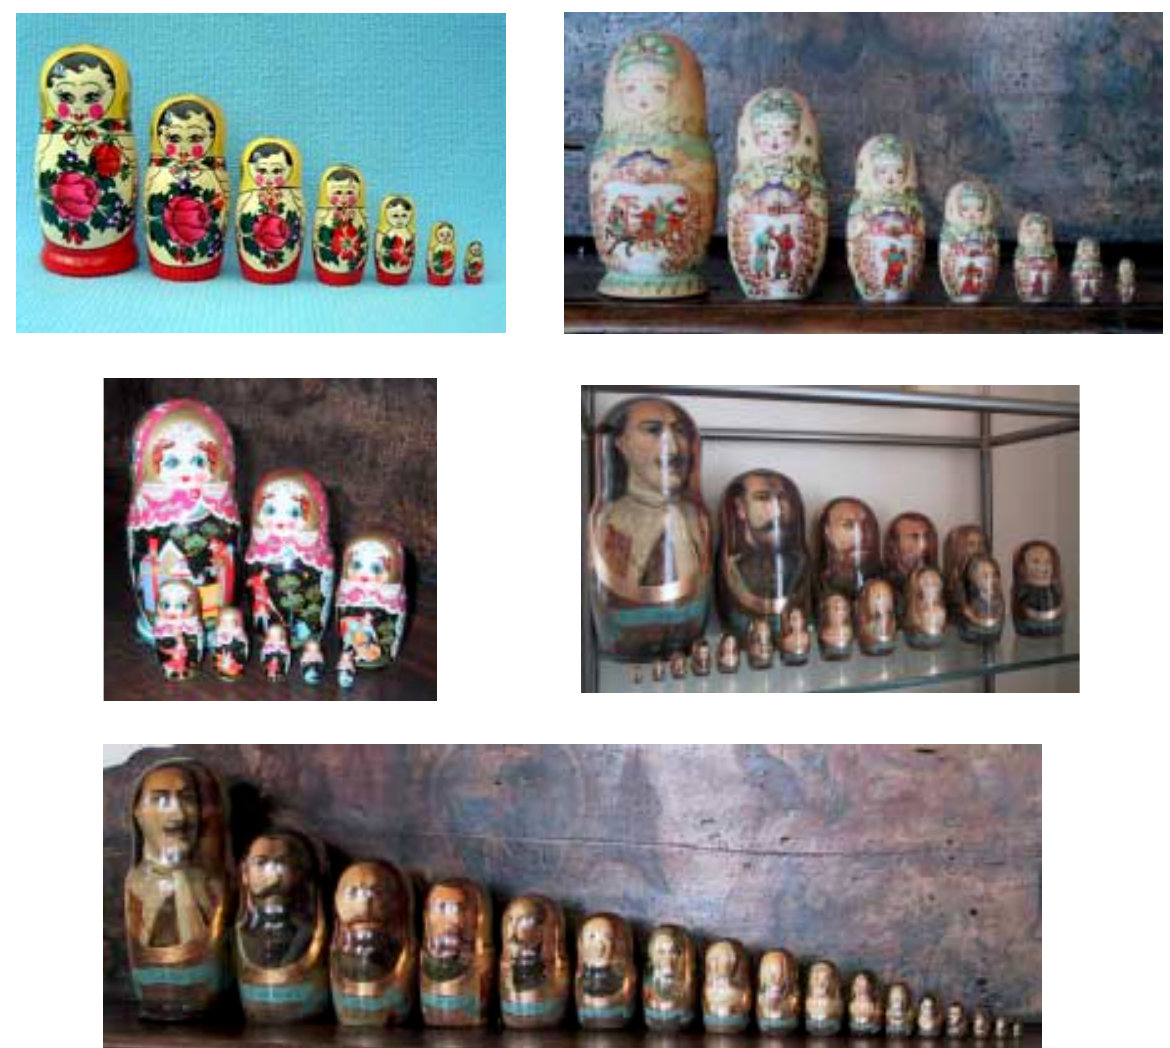
Figure 2 : Examples of